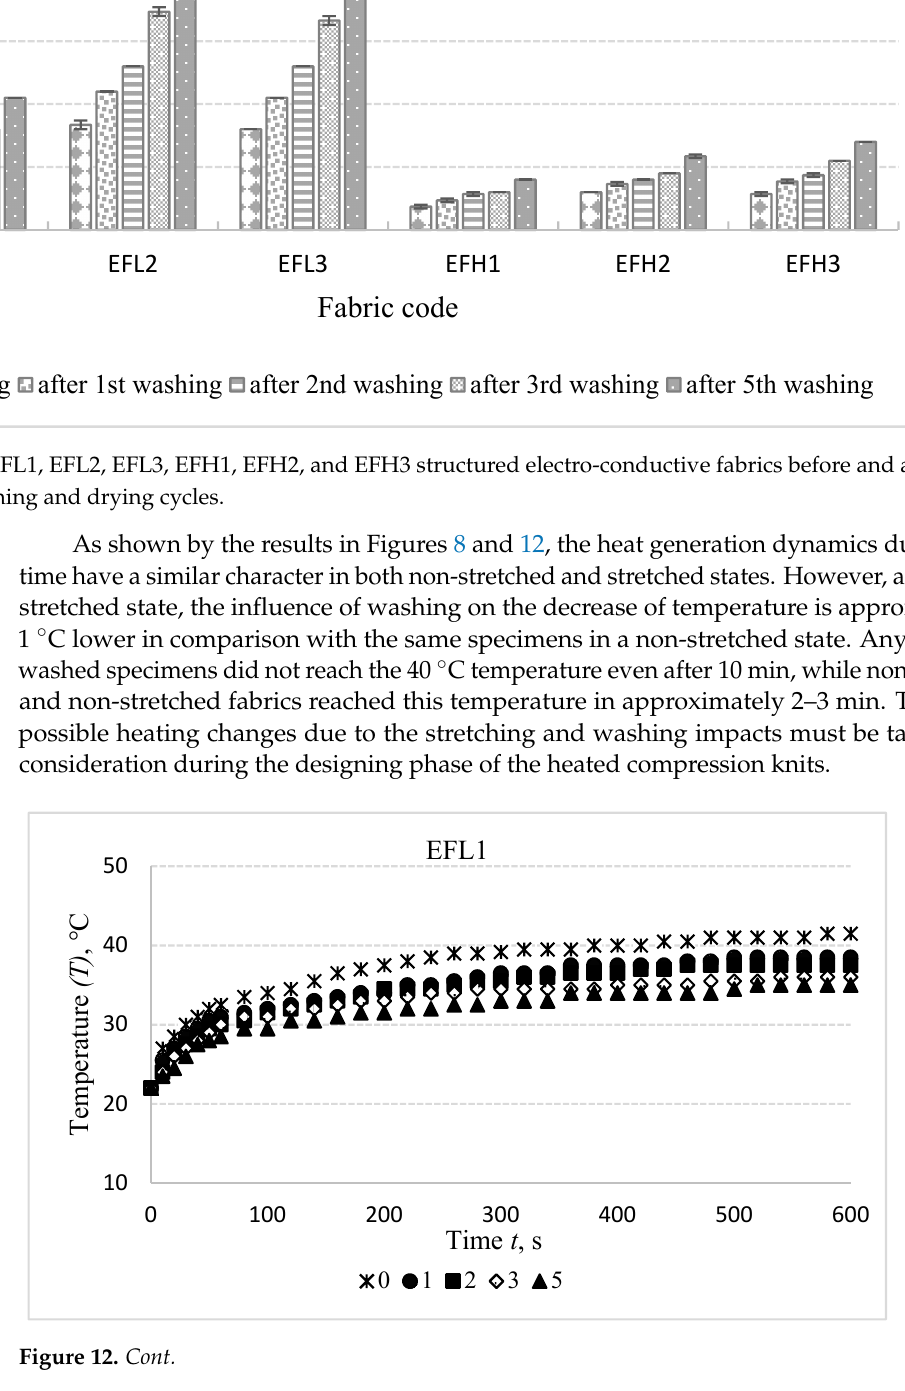
Figure 11. Resistance of EFL1, EFL2, EFL3, EFH1, EFH2, and EFH3 structured electro-conductive